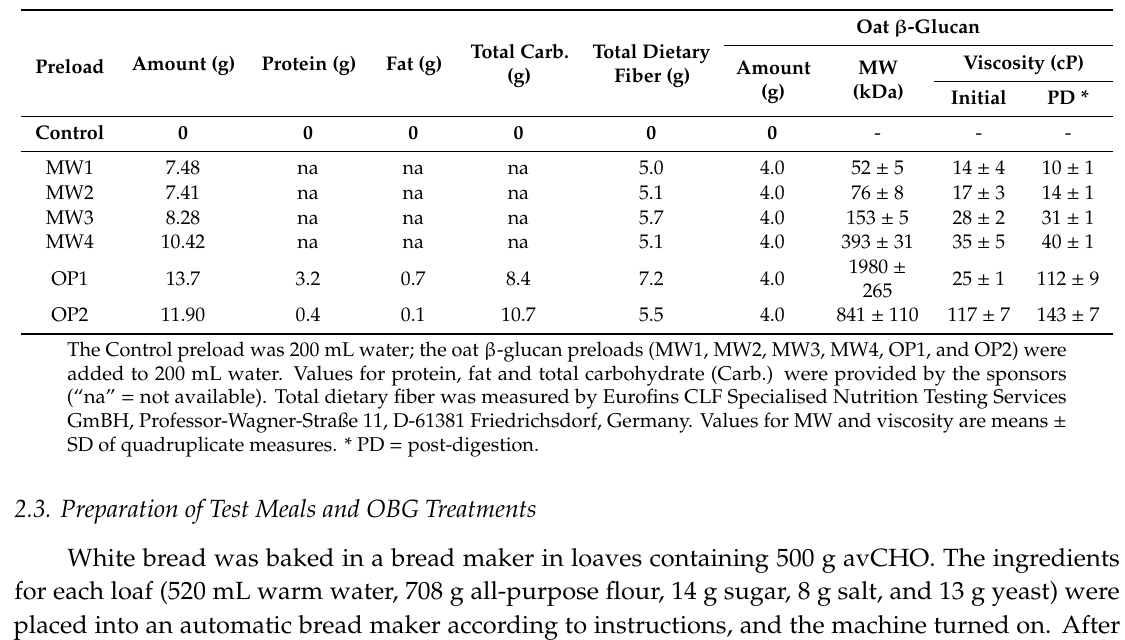
Table 1. Composition of the Control oat β -glucan